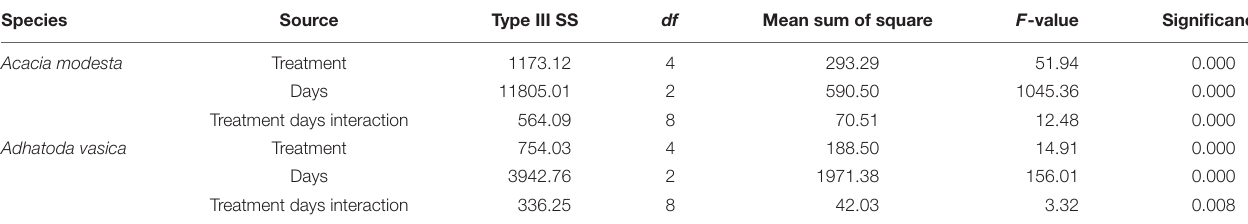
TABLE 3 | The effect of solid waste treatment, duration of days, and their interactions on the growth of Acacia modesta and Adhatoda vasica . Species